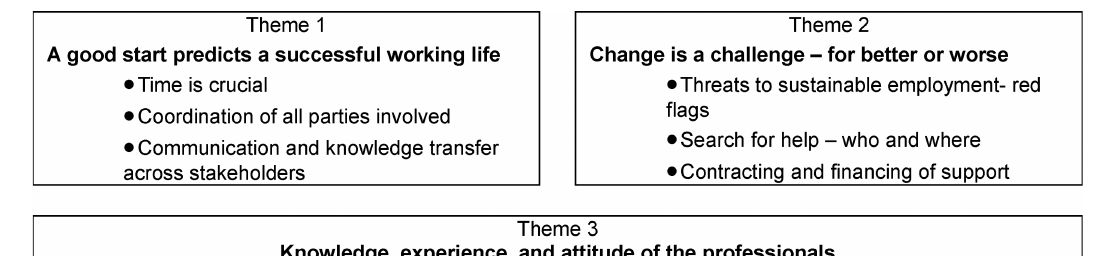
TABLE 2 Main themes and